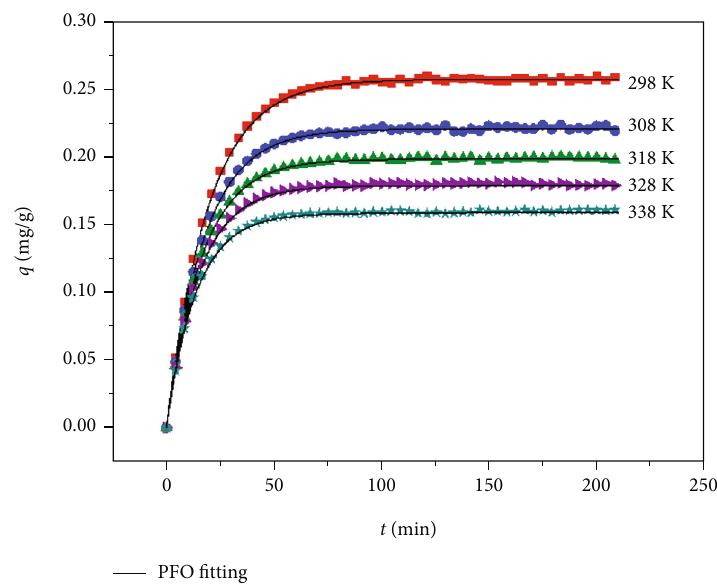
Figure 15: Dynamic curves of HF under di ff erent temperature at